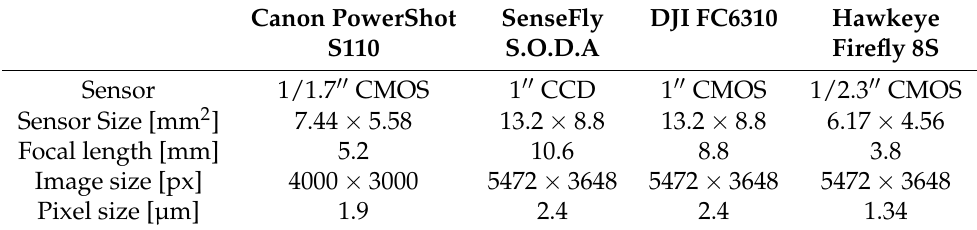
Table 2. Summary of the characteristics of the cameras